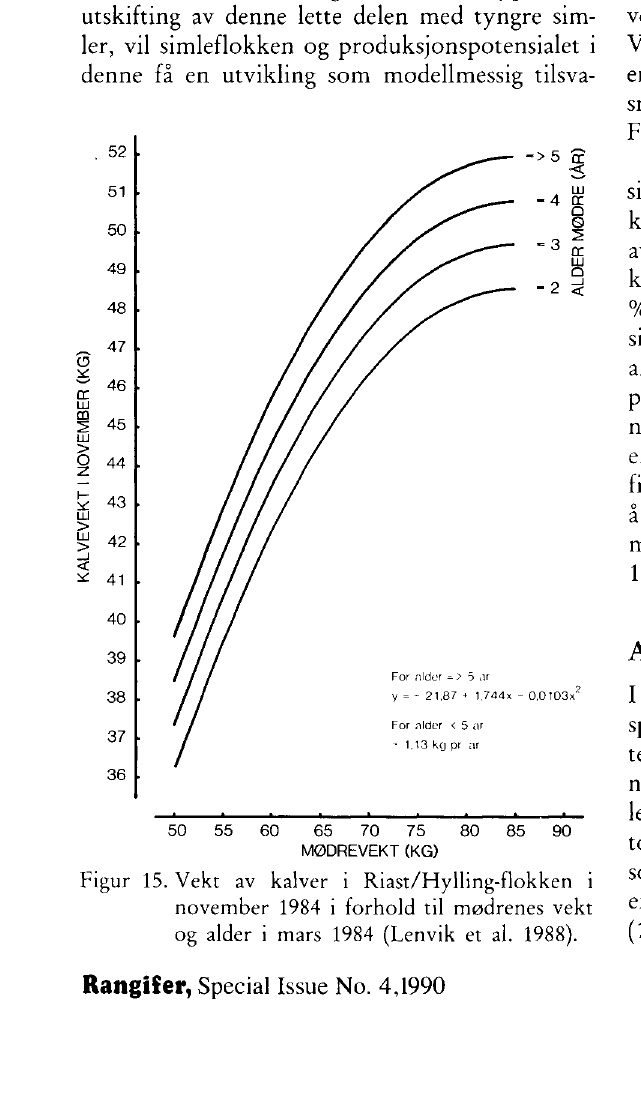
Figur 15. Vekt av kalver i Riast/Hylling-flokken i november 1984 i forhold til mødrenes vekt og alder i mars 1984 (Lenvik et al.